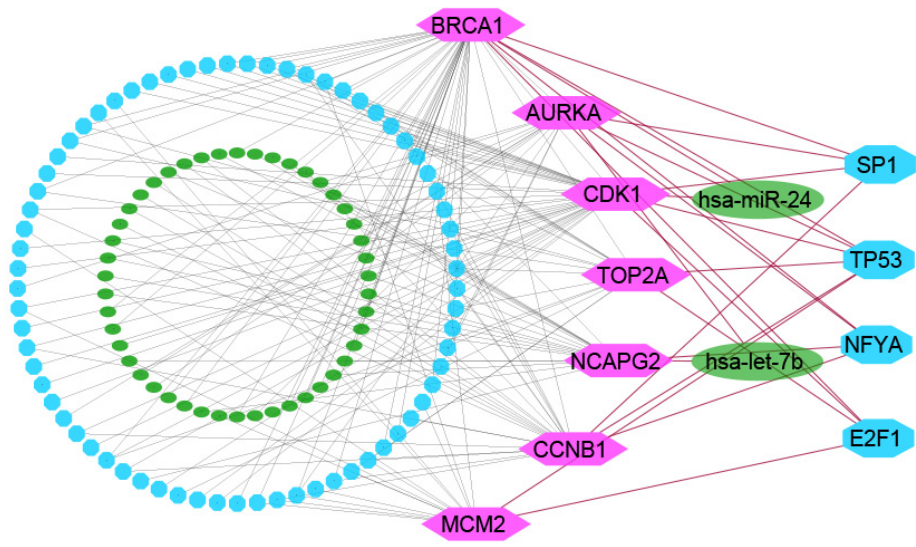
Figure 4. TFs-genes–miRNAs interaction network with KGs. The highlighted pink-color nodes represent the key genes, cyan-color nodes represent the TFs, and other dark-green-color nodes represent miRNAs. The network consists of 131 nodes and 175 edges.